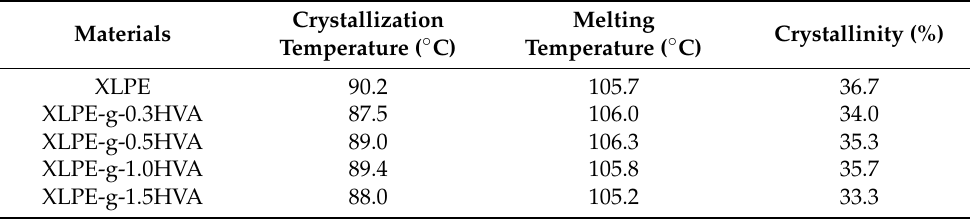
Figure 3. DSC curves of XLPE and HVA-2 grafted XLPE. ( a ) Crystallization and ( b ) melting. Table 2. Melting and crystallization parameters of XLPE and HVA-2 grafted